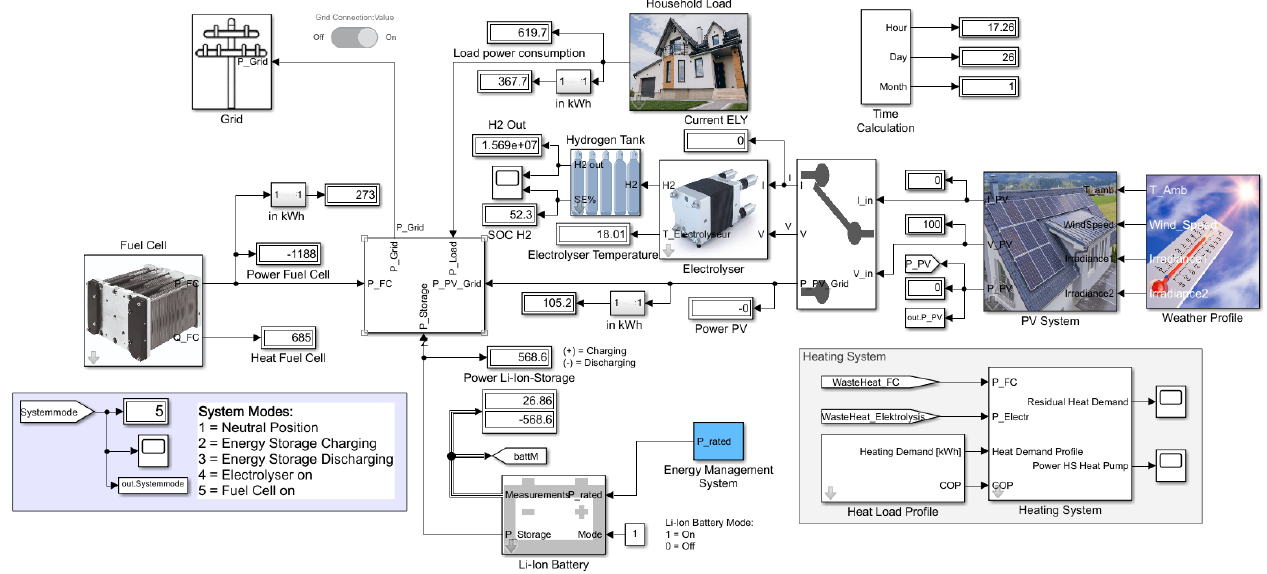
Figure 13. Simulink model of the overall household energy system (image sources: [50,51]). Table 1. PV system characteristics (Type: SMA310M-6X10DW).